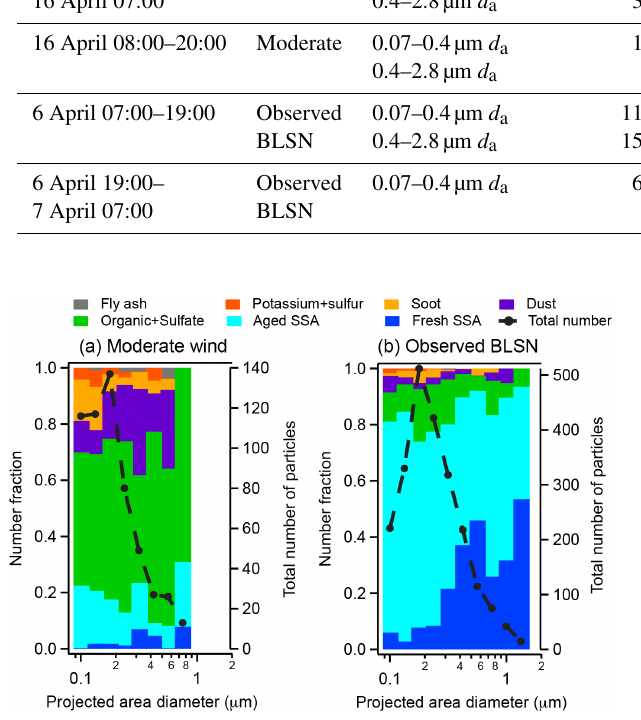
Figure 6. Number fractions of seven individual particle types iden- tified by CCSEM-EDX analysis of stage 3 ( d a 0.07–0.4µm) sam- ples collected during (a) two moderate wind periods (15 April 19:00–16 April 07:00 AKDT and 16 April 08:00–20:00) and (b) two observed blowing snow periods (6 April 07:00–19:00 and 6 April 19:00–7 April 07:00). Total numbers of particles analyzed by CCSEM-EDX per size bin are also shown. SSA refers to sea spray aerosol. All particles were collected on the 0.07–0.4µm d a impactor stage; projected area diameters measured by SEM are shown. Size-resolved counts of particles analyzed by CCSEM-EDX per sample are shown in Fig. S3, and representative SEM images and EDX spectra of the particle types are provided in Fig.